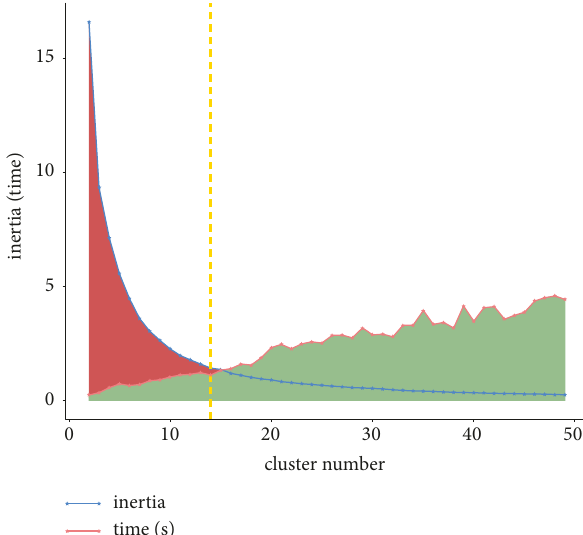
Figure 11: Relationship of K-means cluster number and evaluation